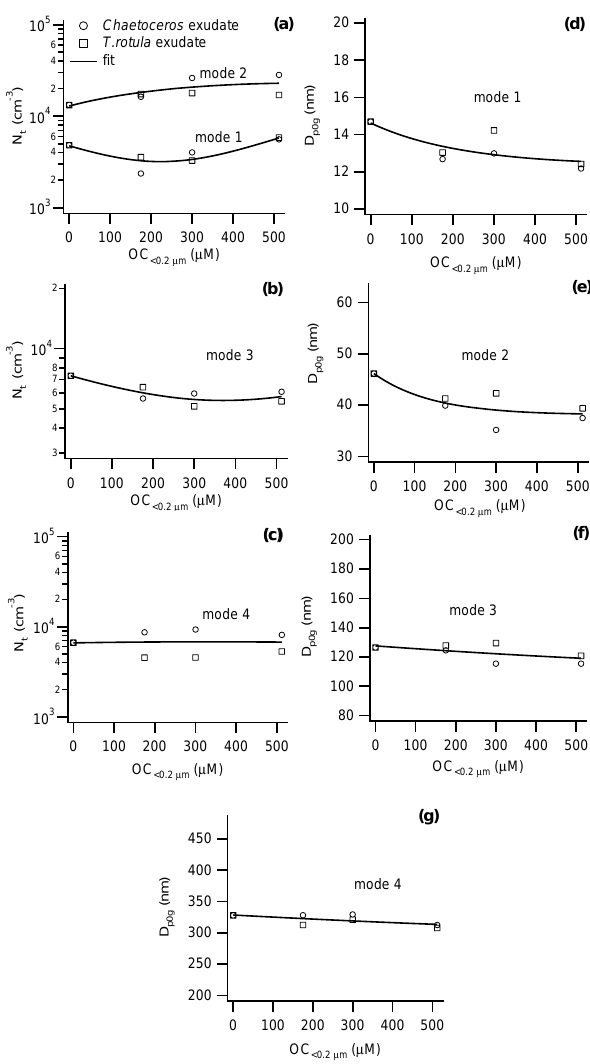
Fig. 8. Particle size distributions obtained for artificial seawater without exudate and seawater proxies (SWP) enriched with T. ro- tula and Chaetoceros exudates at different OC < 0 . 2 µ m concentra- tions. Error bars indicate the variability of the measurements ob- tained from 6 scans during 1h period as ± 1 σ standard deviation.